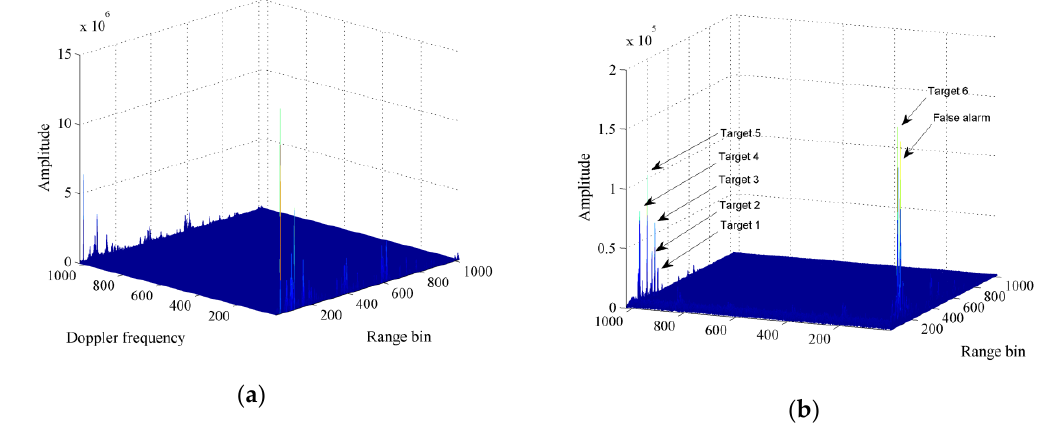
Figure 7. Moving target detection (MTD) algorithm applied to ground vehicle detection. ( a ) Range-Doppler plane without cancelling fixed objects; ( b ) range-Doppler plane with six true targets and a false alarm after eliminating zero frequency and four adjacent frequencies.